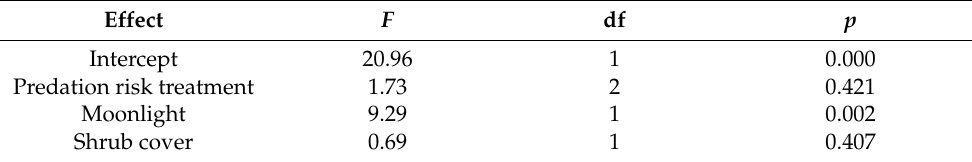
Table 12. Results of the GLM analyzing the effect of experimental and environmental factors on R. rattus vigilance